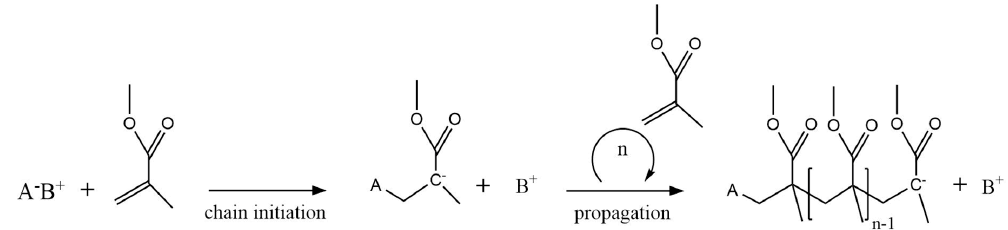
8 of 35 Figure 5 . Additional reactions in free radical polymerization (FRP) of methyl methacrylate as opposed to the basic description displayed in Figure 3; focus on ( a ) chain transfer to monomer and ( b ) chain transfer to polymer twice with a head radical. The chain transfer to polymer reaction is however typically ignored. 2.2. Anionic Polymerization Mechanism The reaction scheme for AP of MMA is much more straightforward, as illustrated in Figure 6. AP is suitable for the polymerization of vinyl monomers with strongly electronegative substituents. AP initiators (A − B + species in Figure 6) are either electron transfer agents or strong anions which